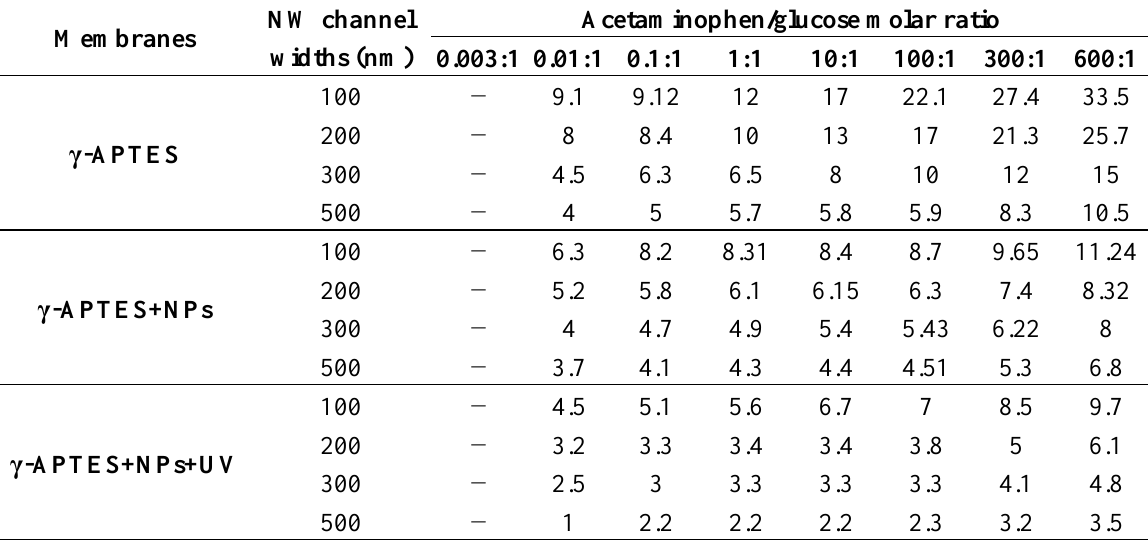
Table 1. Percentage changes of ΔJ (%) measured at V = 5 V for PSWs with different line DS widths, tip-coated with γ-APTES, γ-APTES+NPs and γ-APTES+NPs+UV layers, respectively. The glucose detections were performed under various AP-to-glucose concentration